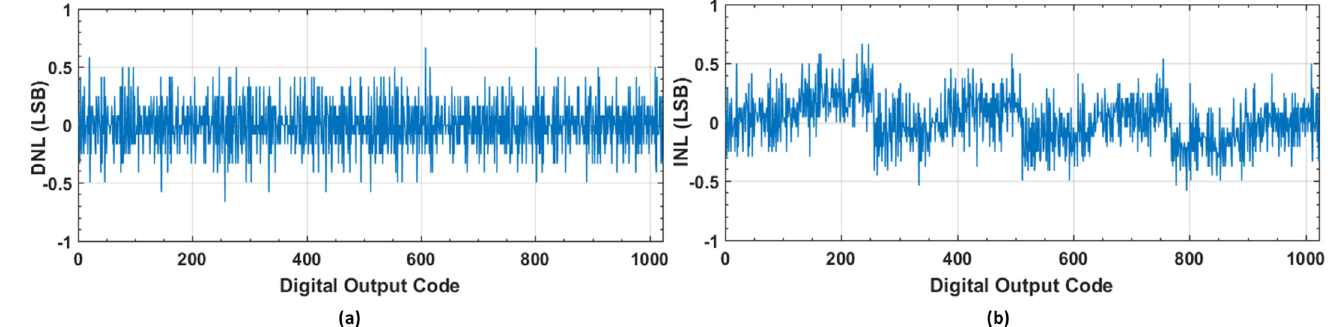
Figure 5. Static performance of the proposed switching with 1% unit capacitor mismatch. ( a ) DNL; ( b ) INL.